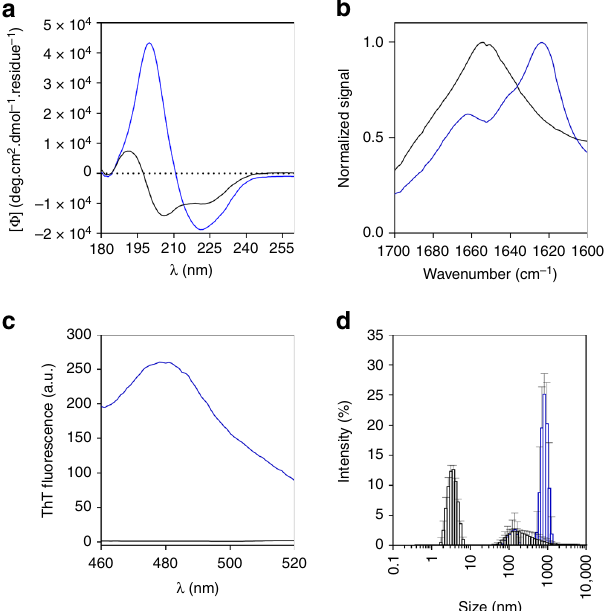
Fig. 2 Structural properties of free and fi brillar Oxm. a – d Free (black) and fi brillar (blue) Oxm at 1 mg mL − 1 in 0.09% saline. Far-UV CD a , ATR-FT-IR, b and ThT emission spectra c , and DLS analysis (Error bars represent standard deviations obtained from eight measurements of the same sample) d